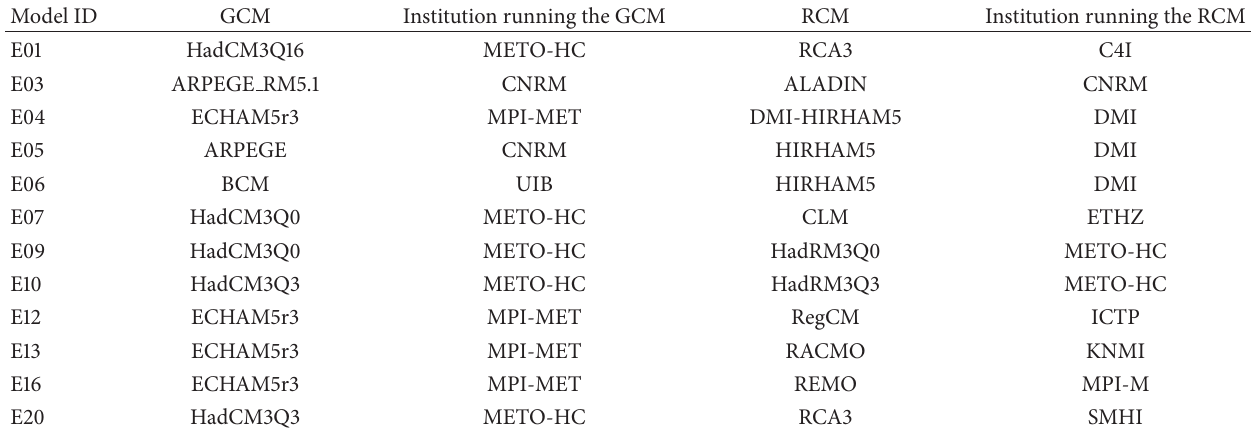
Table 1: Regional climate change projection datasets. Given are the driving GCM, the RCM used for the dynamical downscaling, and the institutions responsible for the GCMs and